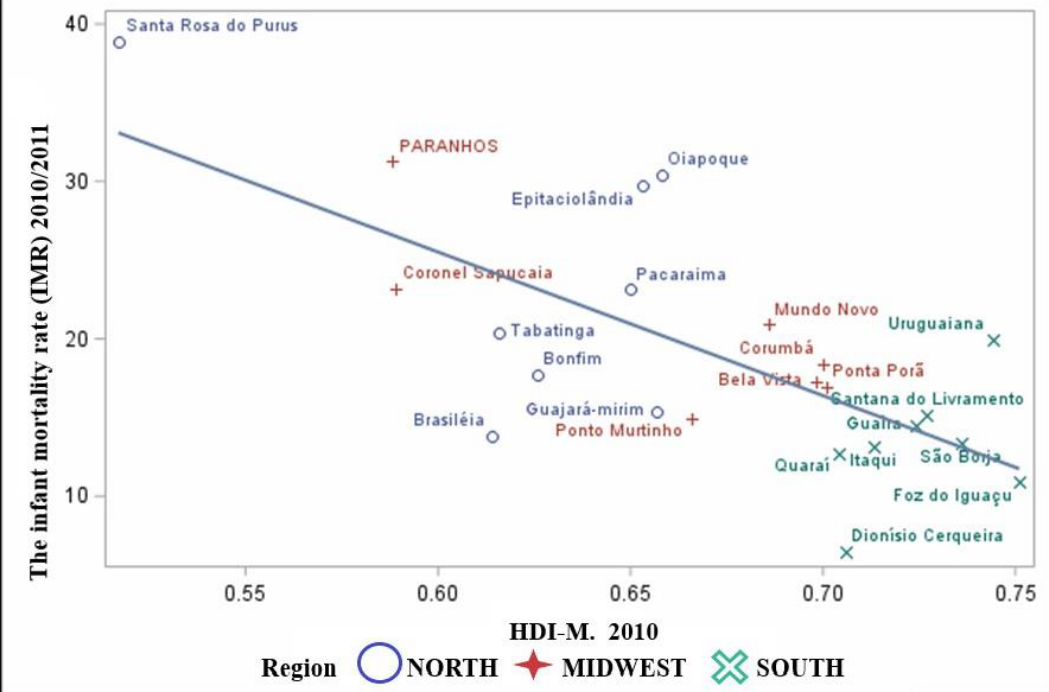
Figure 5. Scatter plot between the means between the averages of the IMRs proportional to the